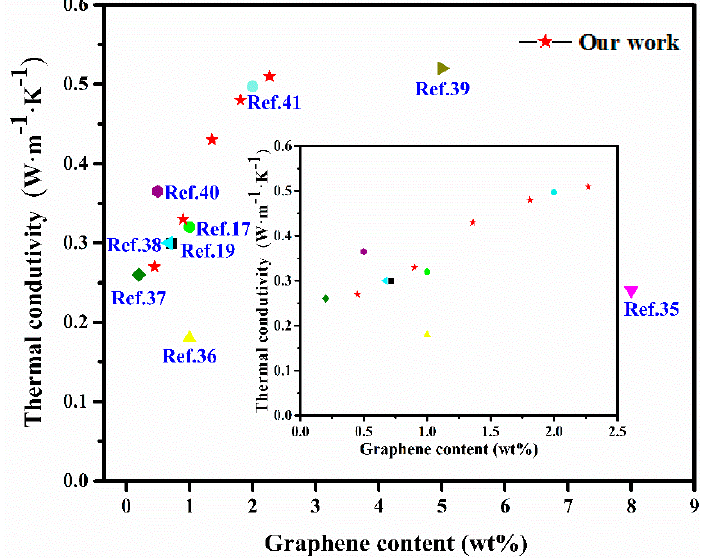
Figure 7. Comparison of thermal conductivity of graphene/silicone rubber composites presented in literature and our work.